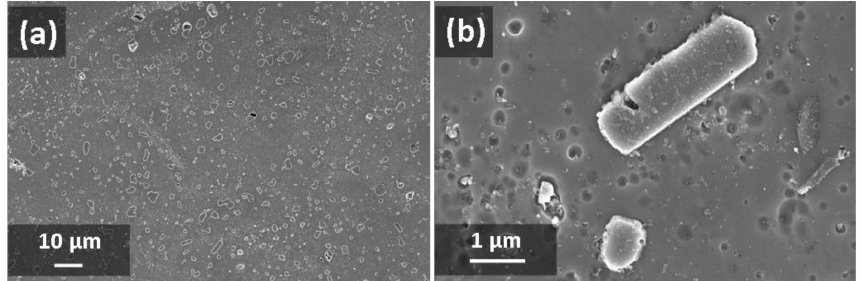
Figure 7. FESEM images of etched microstructure of A357 specimens produced by LPBF, after T6 B,170,3 heat treatment: overall microstructure ( a ) and MG 2 Si precipitates ( b